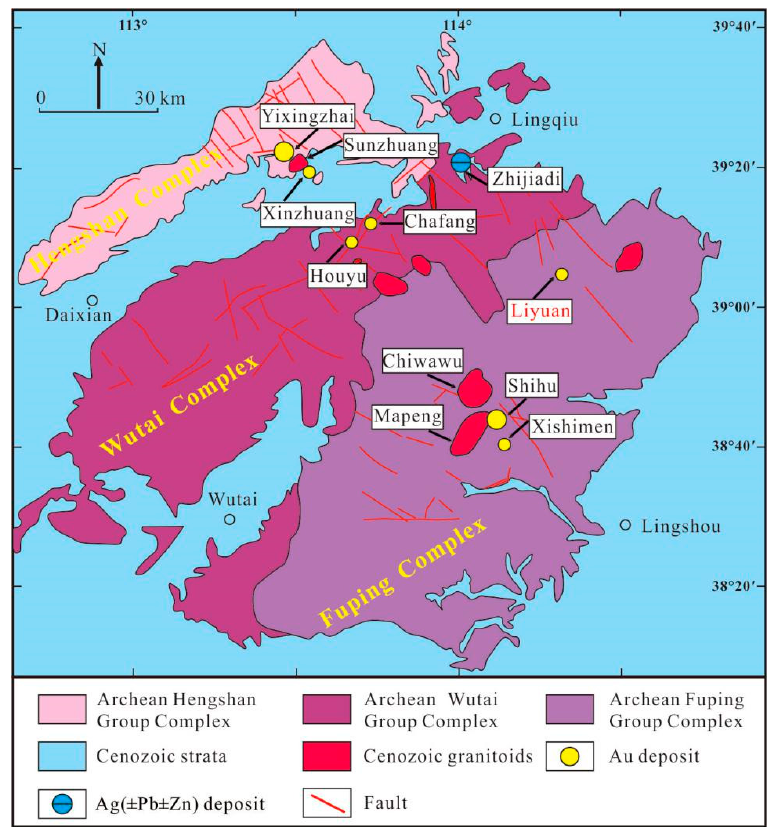
Figure 2. Sketch map of the distribution of gold deposits in the central Taihang Mountains (modified after References